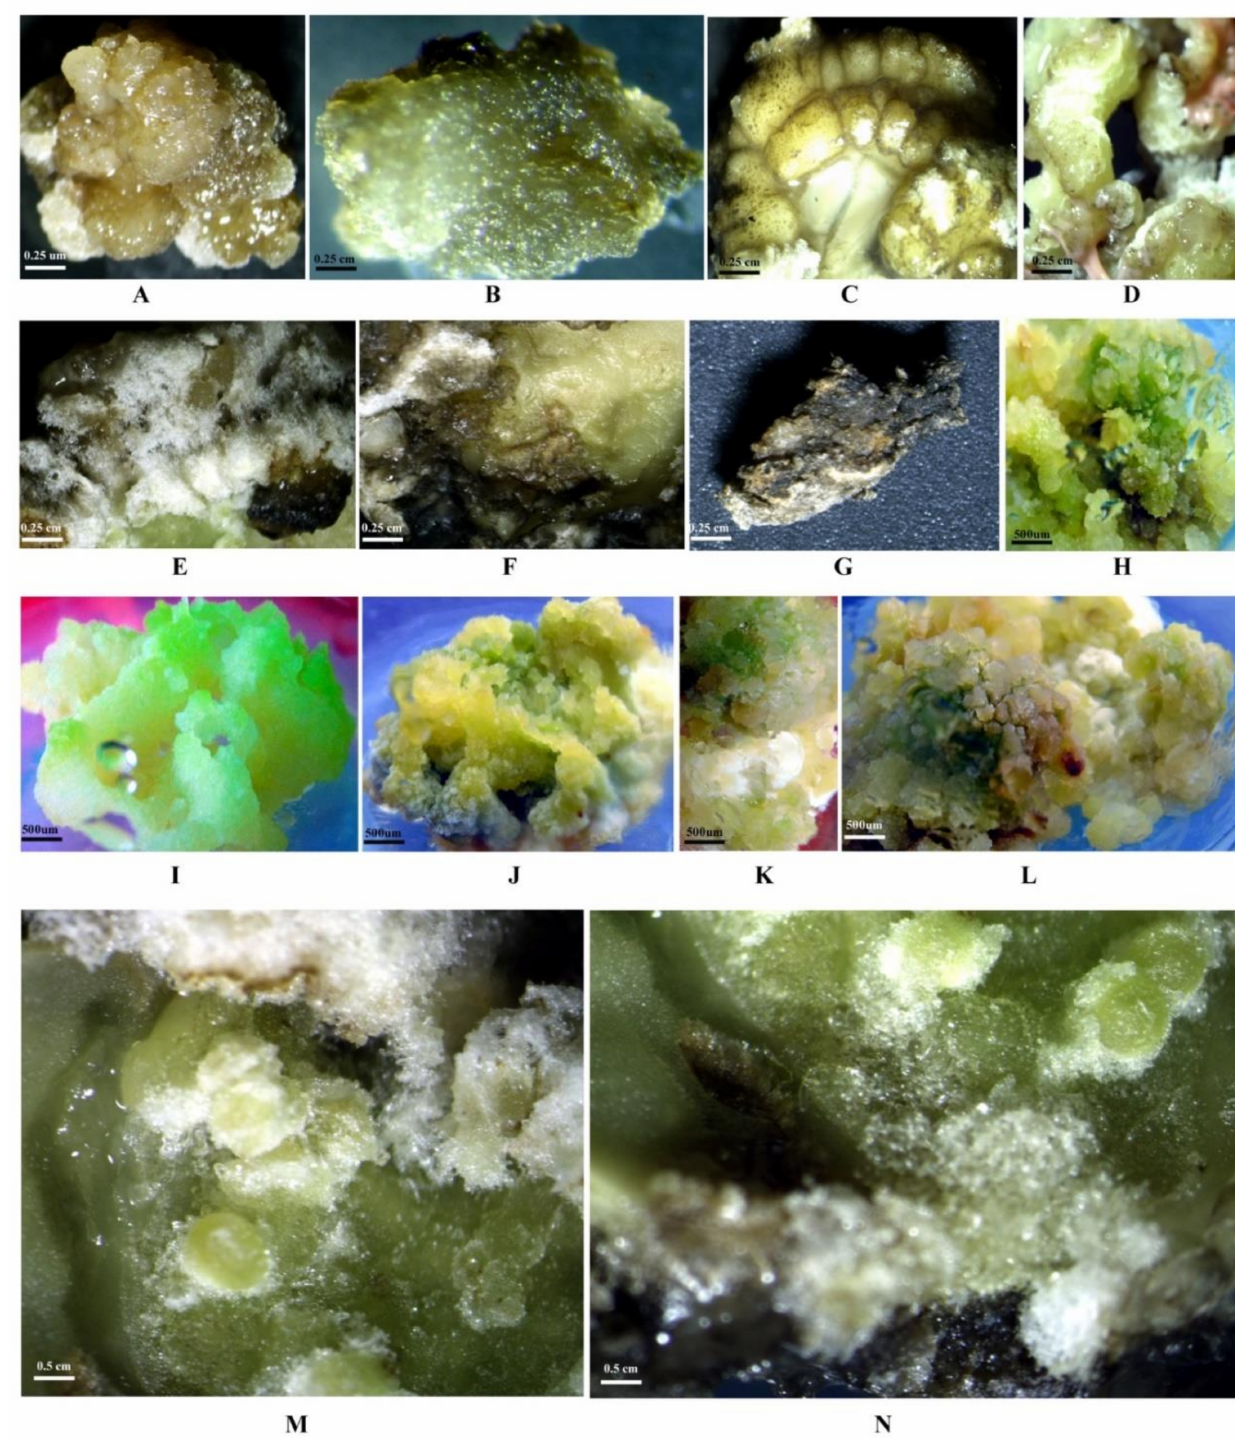
Figure 2. Effect of different concentrations of PEG6000 on survival of calli and formation of nonembryogenic/nonregenerable ( A – G ) and embryogenic/regenerable ( H – N ) callus in selection medium in soybean. ( A ) PEG6000 0% ( w/v ); ( B ) PEG6000 5% ( w/v ); ( C ) PEG6000 10% ( w/v ); ( D ) PEG6000 15% ( w/v ); ( E ) PEG6000 20% ( w/v ); ( F ) PEG6000 25% ( w/v ); ( G ) PEG6000 30% ( w/v ); ( H ) PEG6000 0% ( w/v ); ( I ) PEG6000 5% ( w/v ); ( J ) PEG6000 10% ( w/v ); ( K ) PEG6000 15% ( w/v ); ( L ) PEG6000 20% ( w/v ); M.PEG6000 25% ( w/v ); ( N ) PEG6000 30% ( w/v